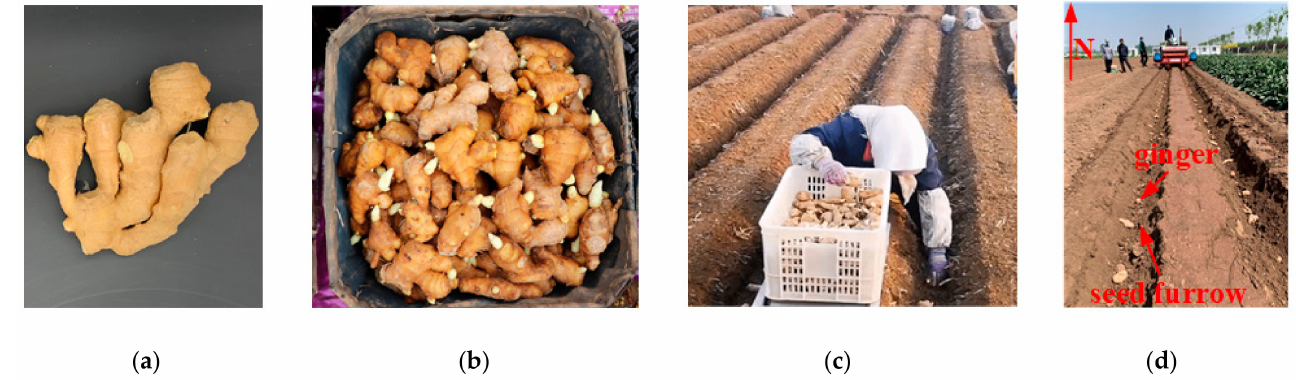
Figure 1. Ginger growing process. ( a ) ginger, ( b ) ginger after sprouting, ( c ) artificial ginger planting, ( d ) mechanical ginger